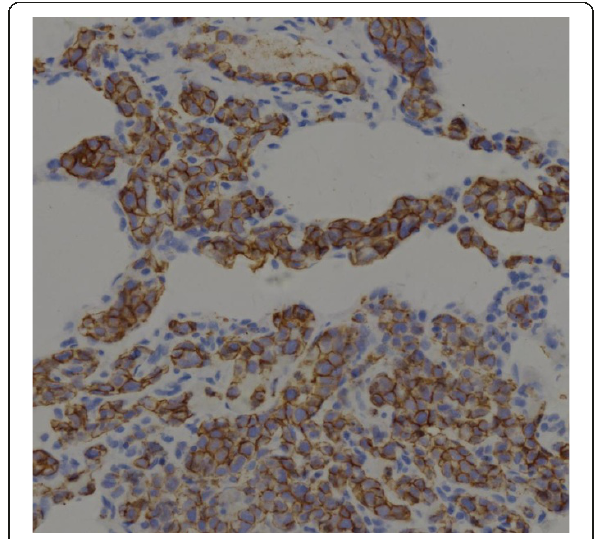
Figure 6 KI-67 immunostain highlights the proliferation of intravascular lymphoma cells,